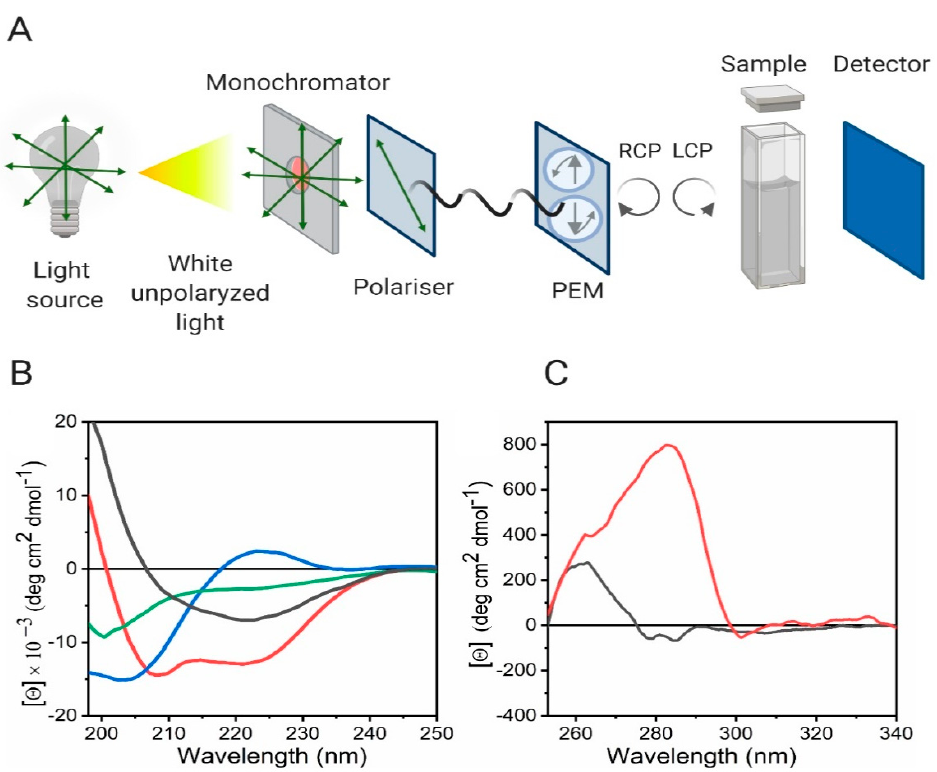
Figure 10. Circular Dichroism as a tool for the study of protein secondary and tertiary structure. ( A ) Schematic representation of the Circular Dichroism instrument configuration. ( B ) Representative Far-UV CD spectra of the characteristic secondary structure motifs detected in proteins and peptides: random-coil (green), α -helix (red), β -sheet (black) and Polyproline II (blue). ( C ) Near-UV–CD spectra of two different proteins, one containing tryptophan and tyrosine (red) and the other only tyrosine (black). This image was created with Biorender.com.